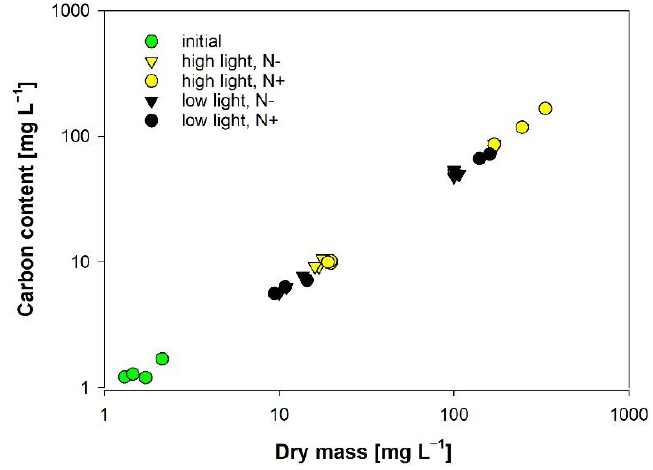
Figure 2. The carbon content of Anabaena torulosa grown in full BG11 medium (N+) and in nitrogen- depleted medium (N−) and under high and low light is about 50% of the total DM (r 2 = 0.99, n = 27).